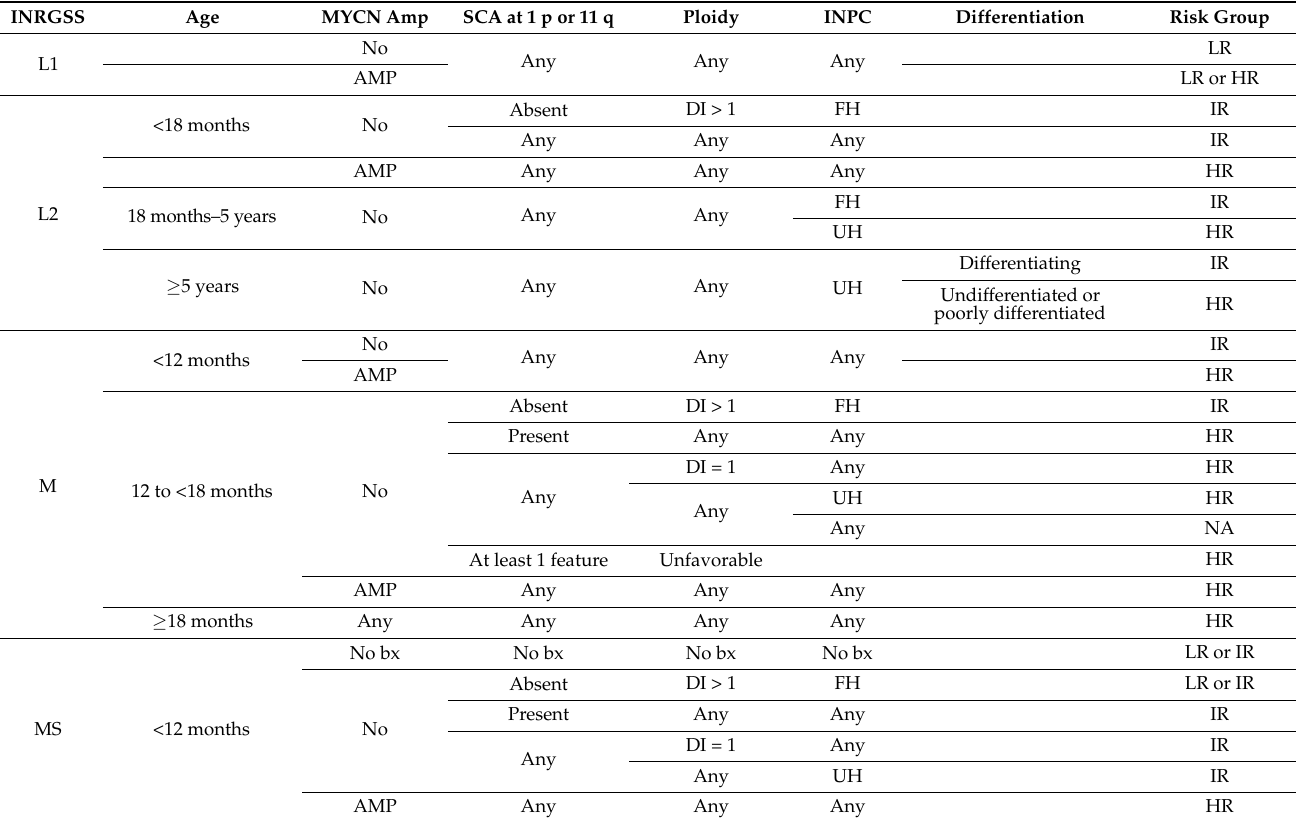
Table 1. International Neuroblastoma Risk Group Staging System revised and updated by the Children’s Oncology Group in